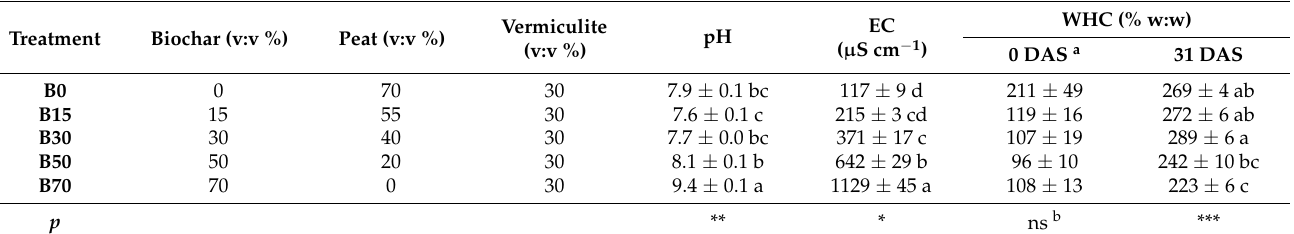
Table 2. pH, electrical conductivity (EC and water holding capacity (WHC) of biochar:peat: vermiculite mixtures